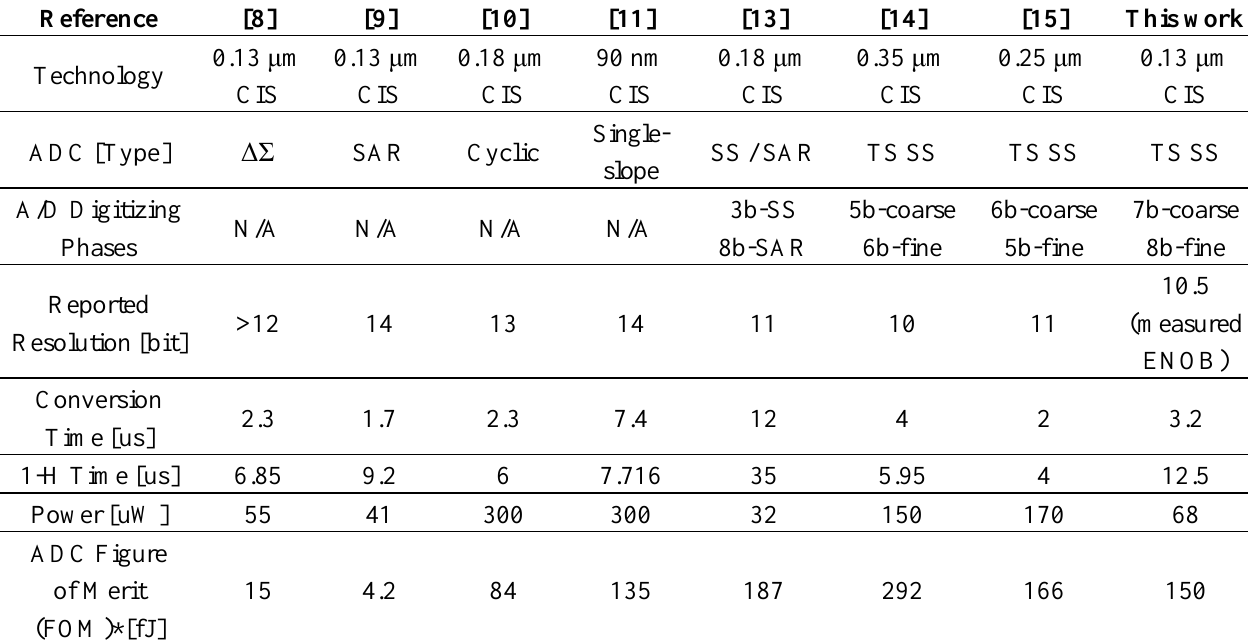
Table 2. ADC performance